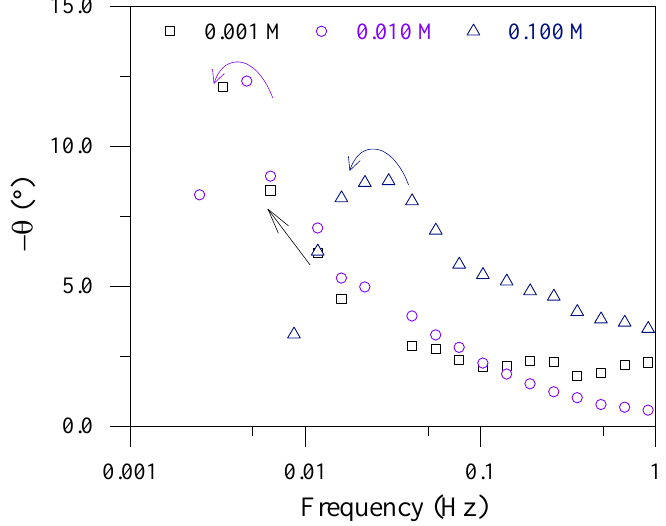
Figure 8. Bode plot of the phase angle versus the frequency for the three H x PO 43 − x concentration conditions at pH 7.2. The bias potential applied comprehends the last plateau region of each experimental condition.